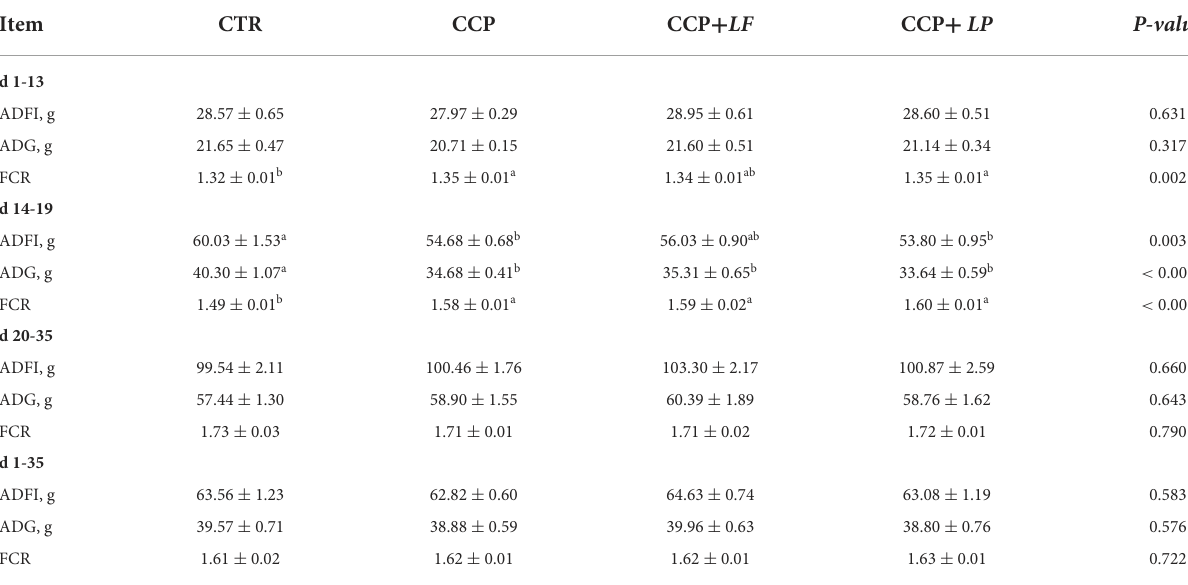
TABLE 3 The growth performance of broilers during the trial, n = 6.